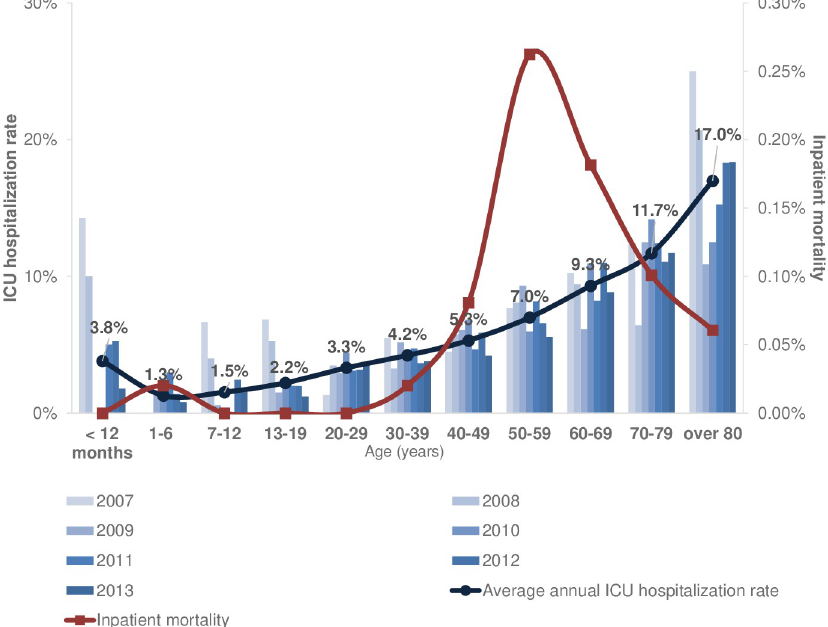
Fig 3. The intensive care unit (ICU) hospitalization rate and inpatient mortality by age group through 2007–2013.